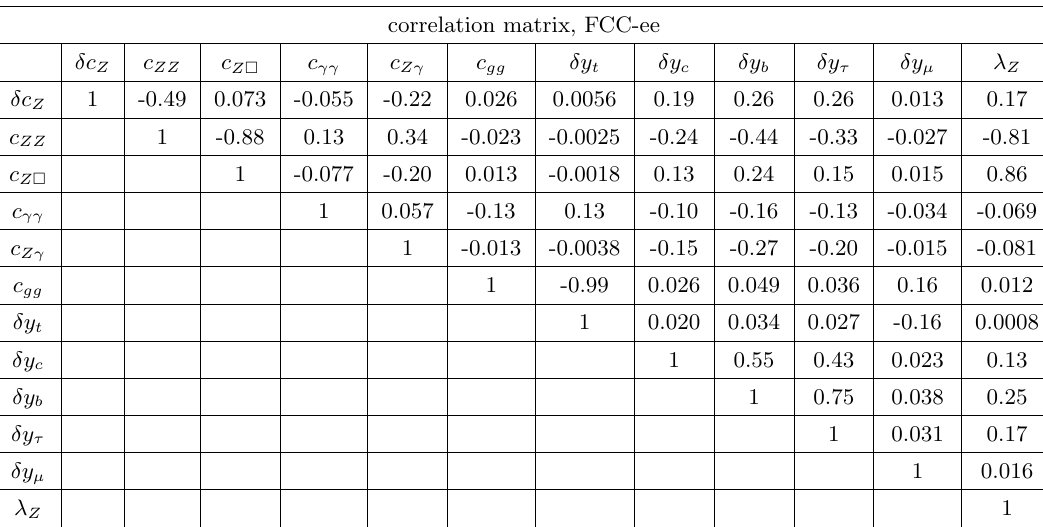
Table 13 . The corresponding correlation matrix for the FCC-ee one sigma bounds in table